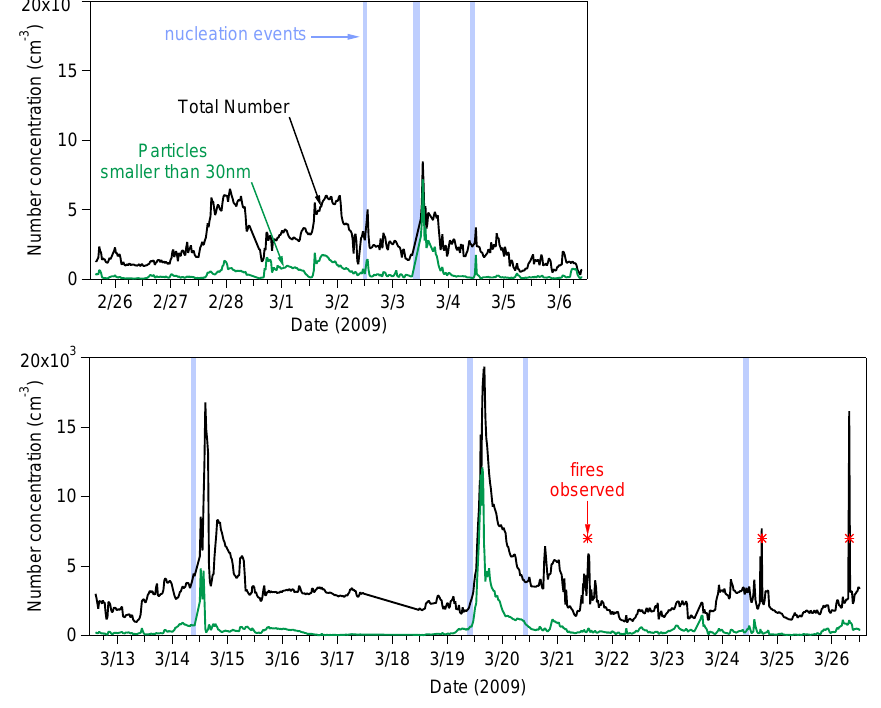
Fig. 5. Time series of total particle number (15nm < D p < 500nm, black line) and particles smaller than 30nm (15nm < D p < 30nm, green line) measured by the SMPS. Nucleation events (light blue bands) were identified based on increases in the concentration of air ions (2nm < D p < 10nm, Pikridas et al., 2011). The time delay between nucleation events and the increase in SMPS particle concentrations is likely due to growth of the particles to the SMPS size range. On 24 March, the nucleated particles did not grow to the SMPS size range. Fires observed from the field site (red stars) are characterized by increases in the concentration of larger particles. SMPS data were not available on 6–12